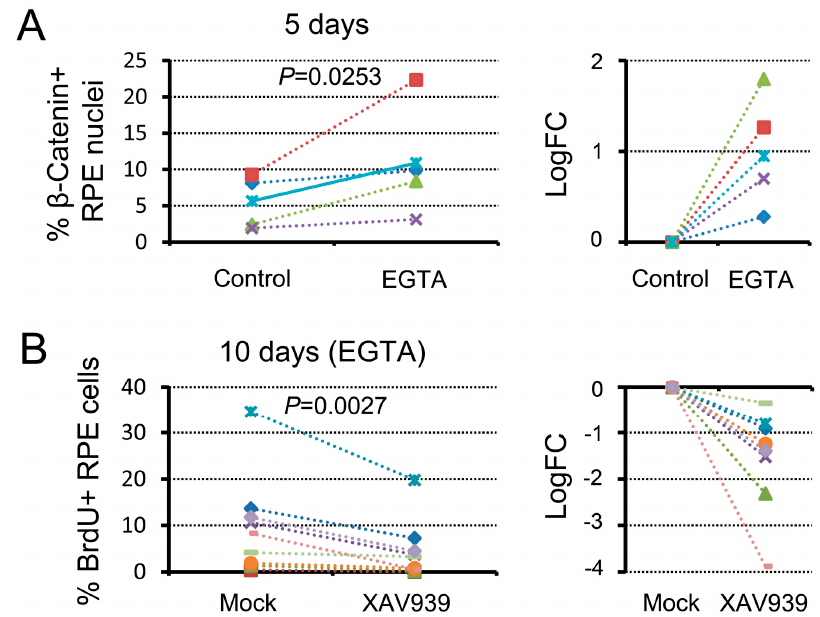
Figure 4. Attenuation of cell–cell contact promotes cell cycle re-entry of RPE cells via β -catenin signaling. ( A ) Differences in the ratio of β -catenin+ nuclei in the Center of the RPE on day 5 between normal saline (control) and EGTA treatment. The right hand graph shows the relative changes after EGTA treatment, and was plotted in log 2 (fold change). The value increased significantly (Sheffe’s pairwise comparison test following the Friedman test, p = 0.0253) after EGTA treatment; ( B ) Effect of a β -catenin signaling inhibitor, XAV939, on cell cycle re-entry of RPE cells in the condition of EGTA treatment (9 newts). The left hand graph shows the proportion of BrdU+ cells in the Center of the RPE on day 10, and the right hand graph shows the relative changes in the presence of XAV939. The value decreased significantly (Sheffe’s pairwise comparison test following the Friedman test, p = 0.0027) in the presence of XAV939.